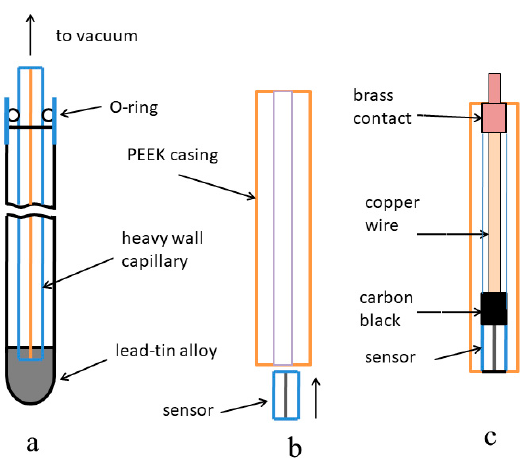
Figure 1. A scheme of a fabrication of a solid lead–tin microelectrode: ( a ) a setup for filling the heavy wall capillary with a lead–tin alloy; ( b ) placing a sensor in PEEK casing; ( c ) a final scheme of a construction of a solid lead–tin microelectrode.